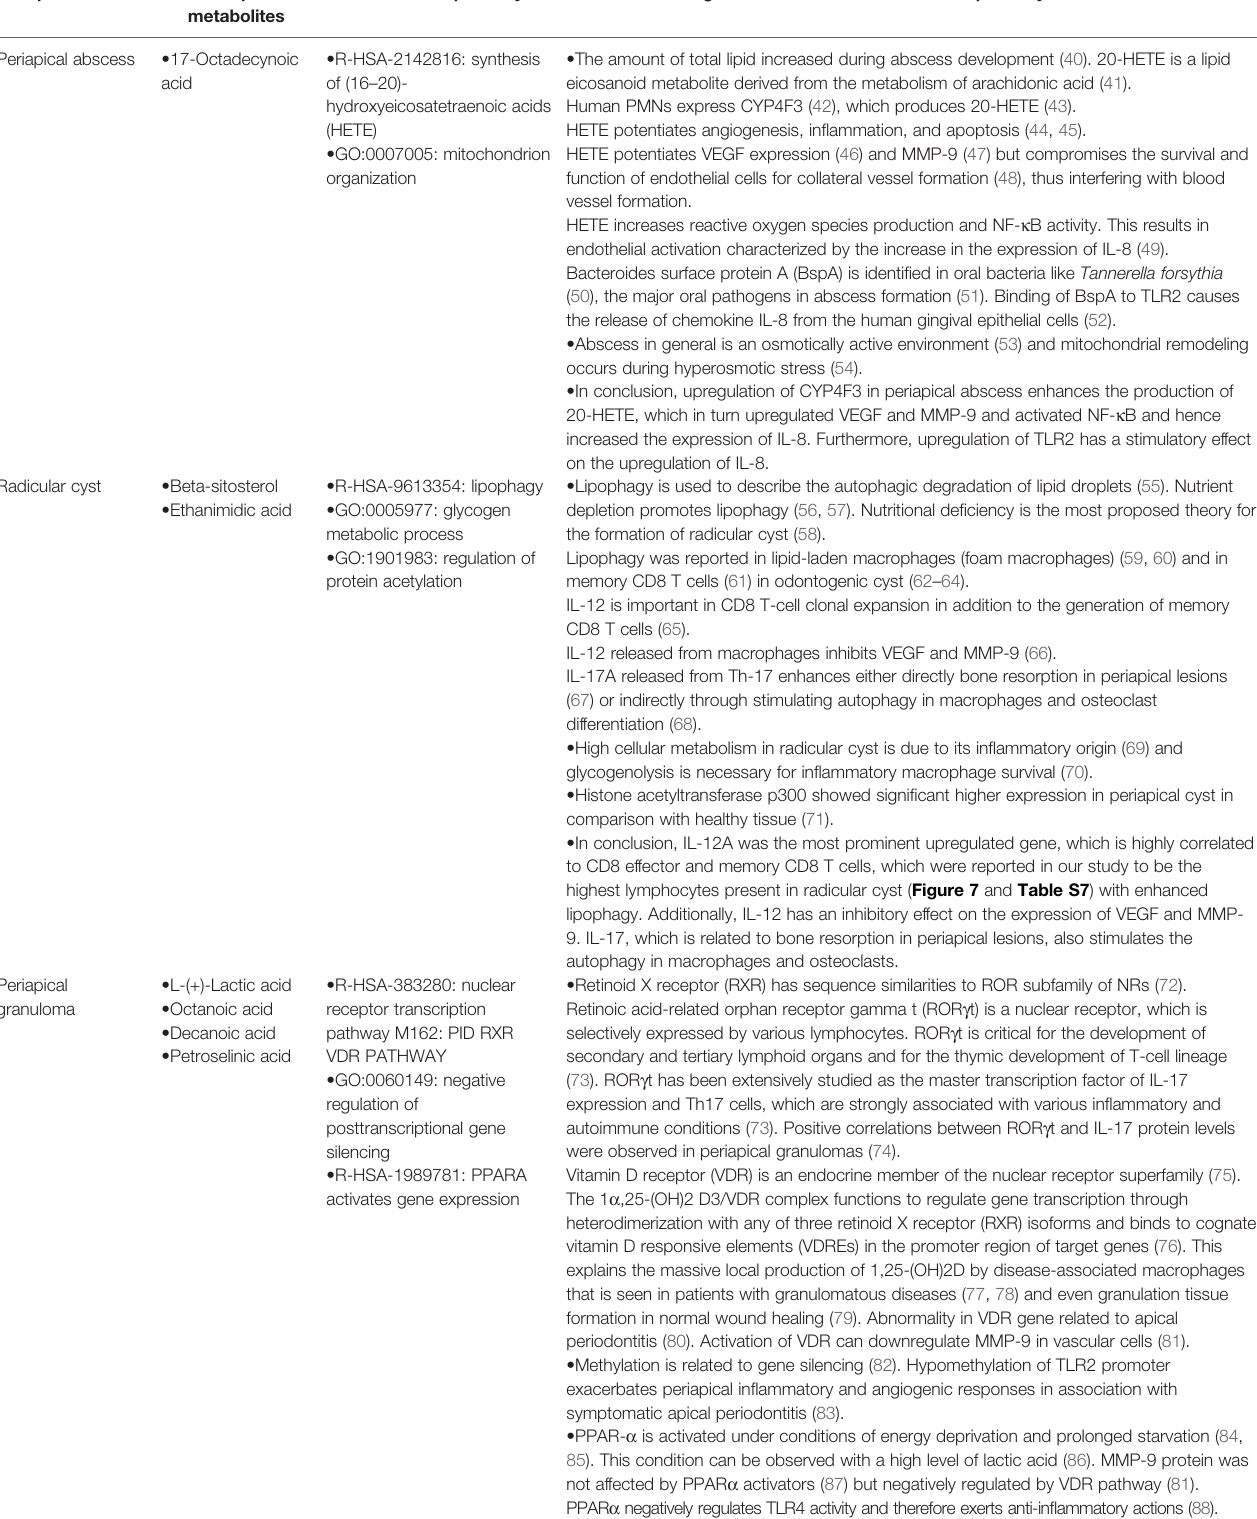
TABLE 4 | The relation between the unique metabolites, enrichment pathways, and the related functional genes in periapical lesions and healthy controls.